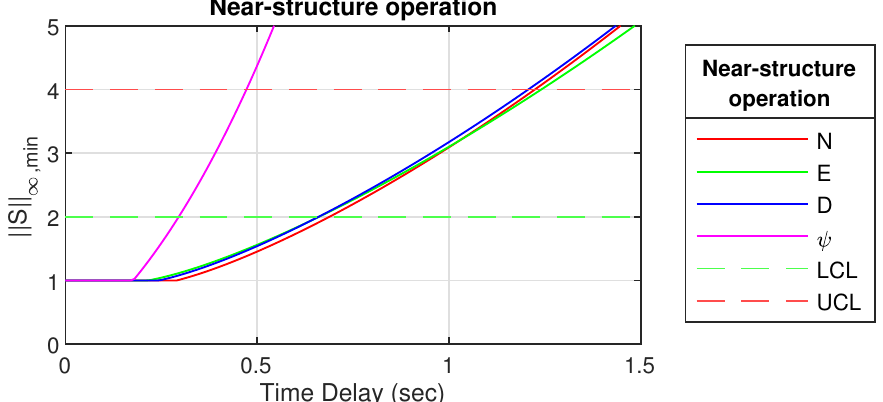
Figure 13. (cid:107) S (cid:107) ∞ , min for Near-structure operation with upper and lower control bound.